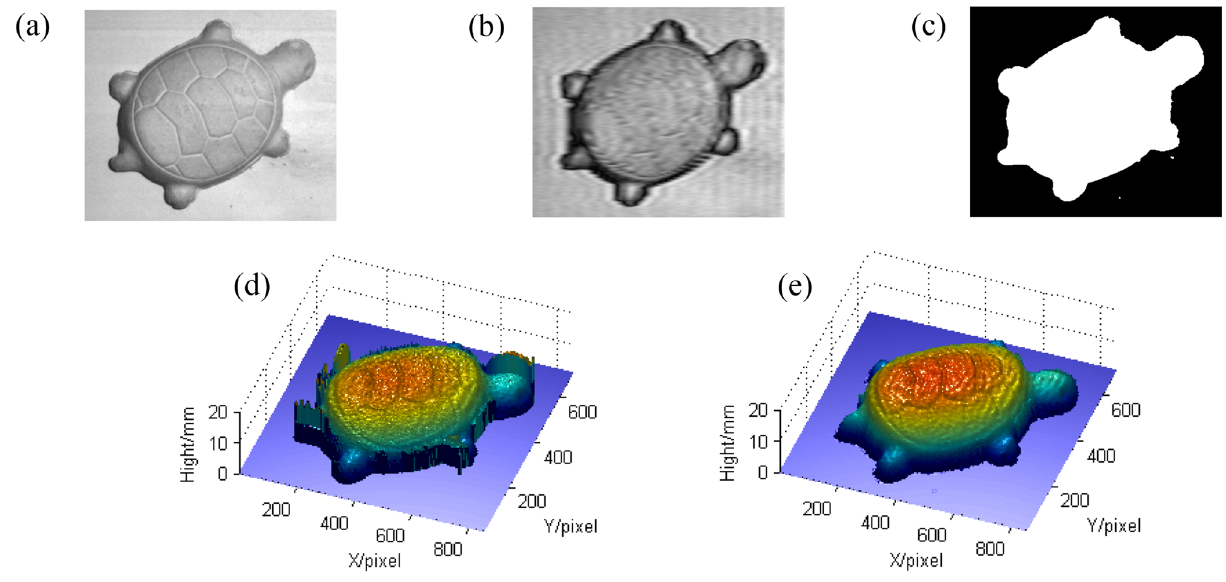
Figure 7. The comparison of reconstructed turtle models before and after using the mask: ( a ) the measured turtle; ( b ) the modulation; ( c ) the mask; ( d ) the reconstructed turtle before using the mask; ( e ) the reconstructed turtle after using the mask.